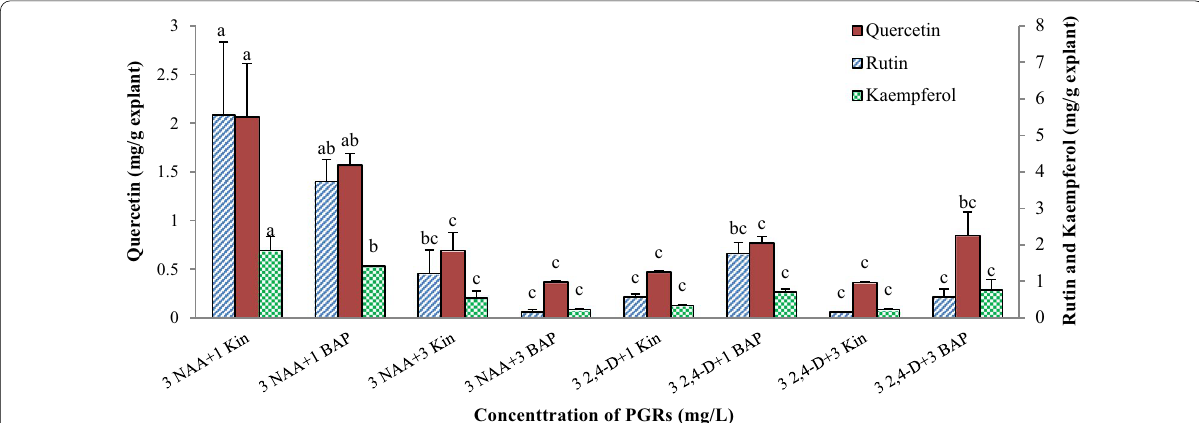
Fig. 3 The effect of the plant growth regulators type and concentrations on the amount of rutin, quercetin and kaempferol in the callus cultures of M. azedarach L. Bars with different letters indicate a significant difference ( P